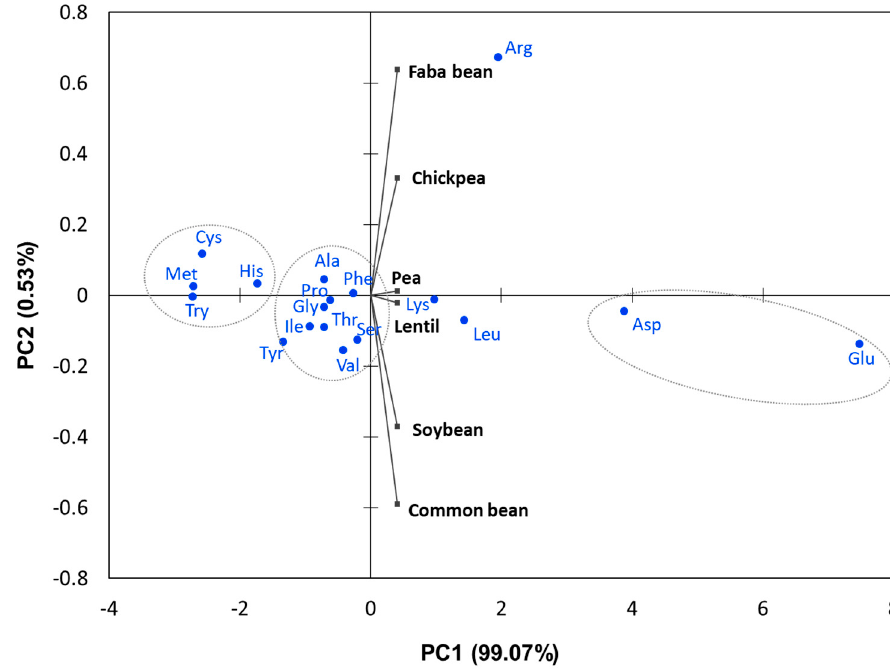
Figure 1. Principal component analysis (PCA) of amino acid data (meta-analysis) from Table 2. The biplot shows amino acid data and legume crops as vectors. Vectors that are close together are correlated in terms of the observed amino acid pool for each crop. PCA analysis was employed to illustrate relationships between amino acids and legume species using the R statistical package (R Development Core Team, 2018, www.Rproject.org).